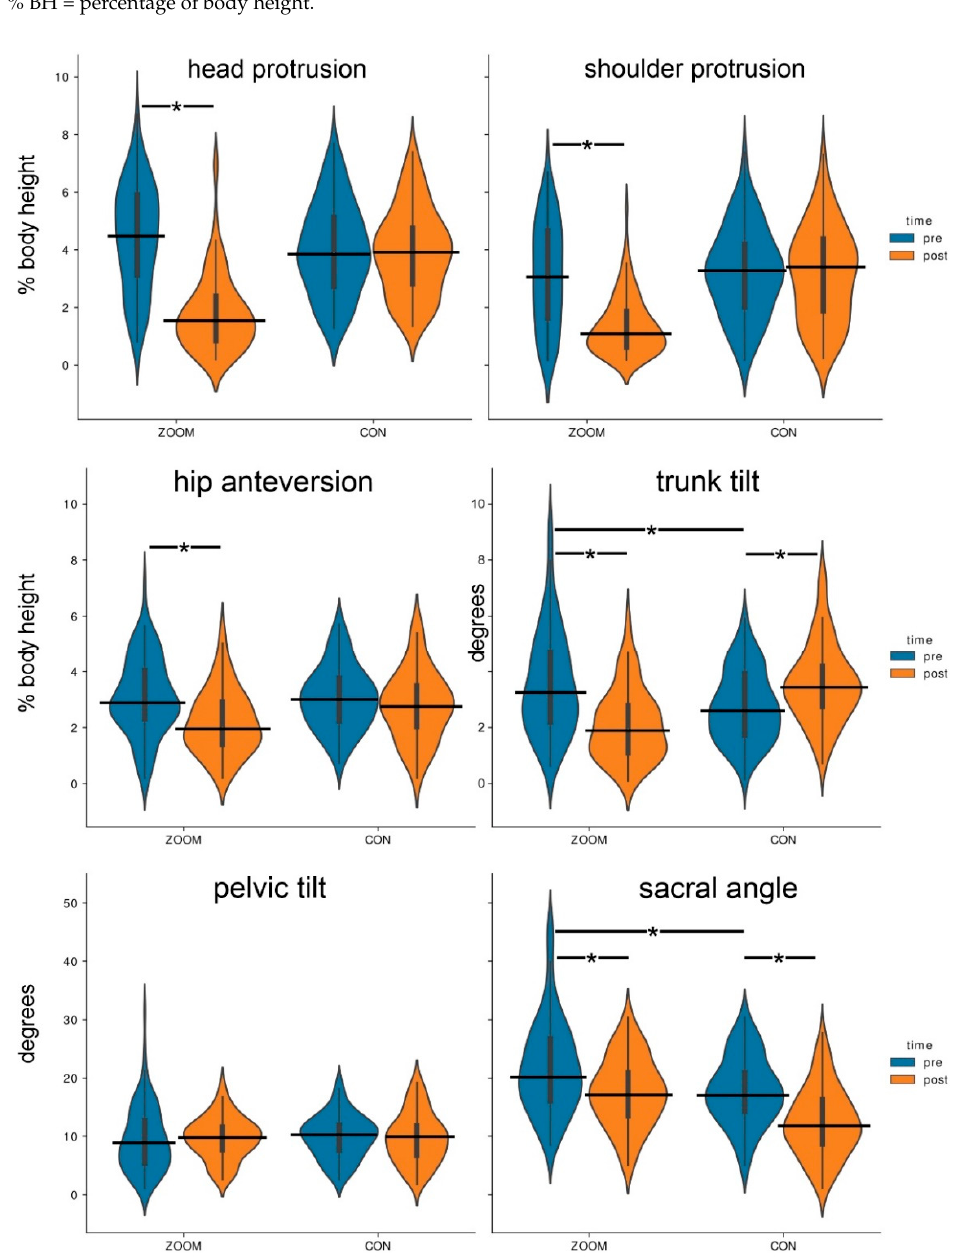
Figure 3. Violin plots of the development of the posture parameters of the training group (ZOOM) and the control group (CON). The horizontal lines mark the median, * = significant difference ( p < 0.05).